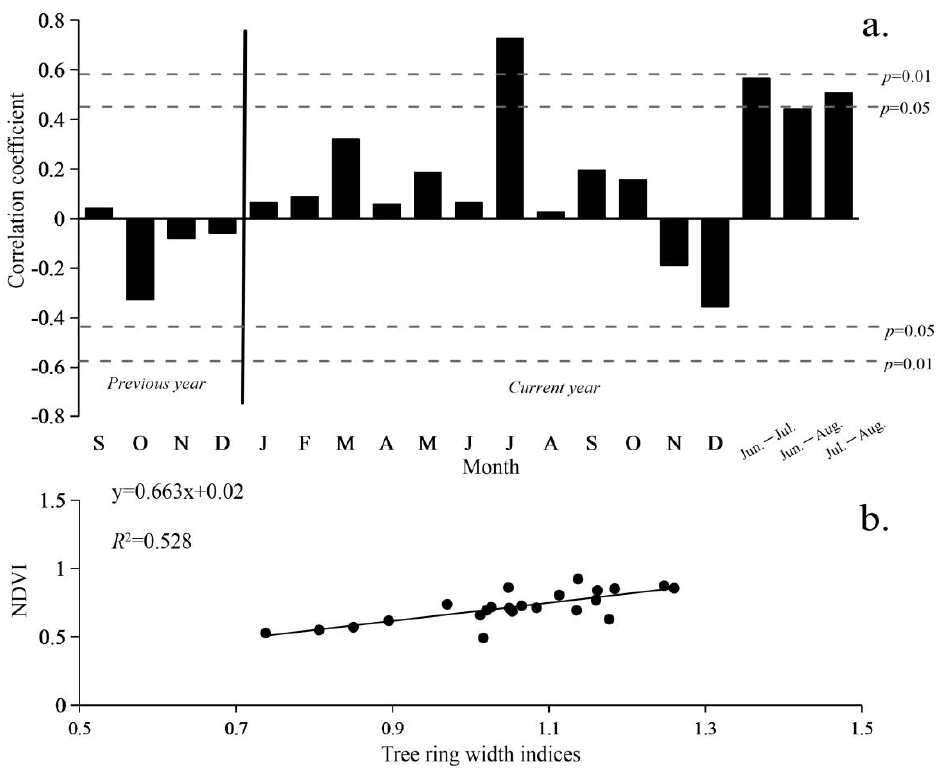
Figure 5. Correlation between TBM NDVI and residual chronology (RES) ( a ). Relationship between July NDVI and residual chronology (RES) during their common period of AD 1991–2013 ( b ).